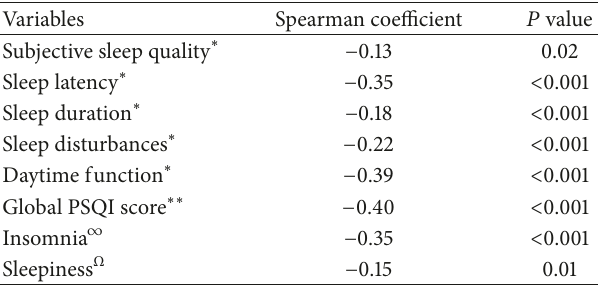
Table3:Therelationofsleepqualitywithsexualfunctioninwomen.